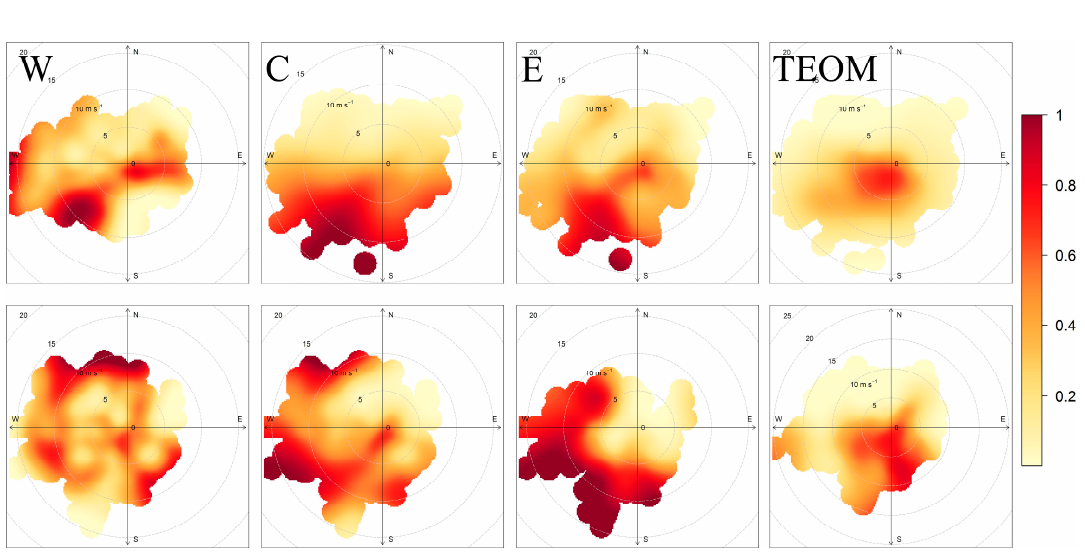
Figure 9. Top: Conditional bivariate probability function (CBPF) calculated from mean Speck values in the three groups of units: western (W), city center (C), and eastern (E), compared to CBPF from TEOM data. Calculated from the first period data. Bottom: The same for the second period.